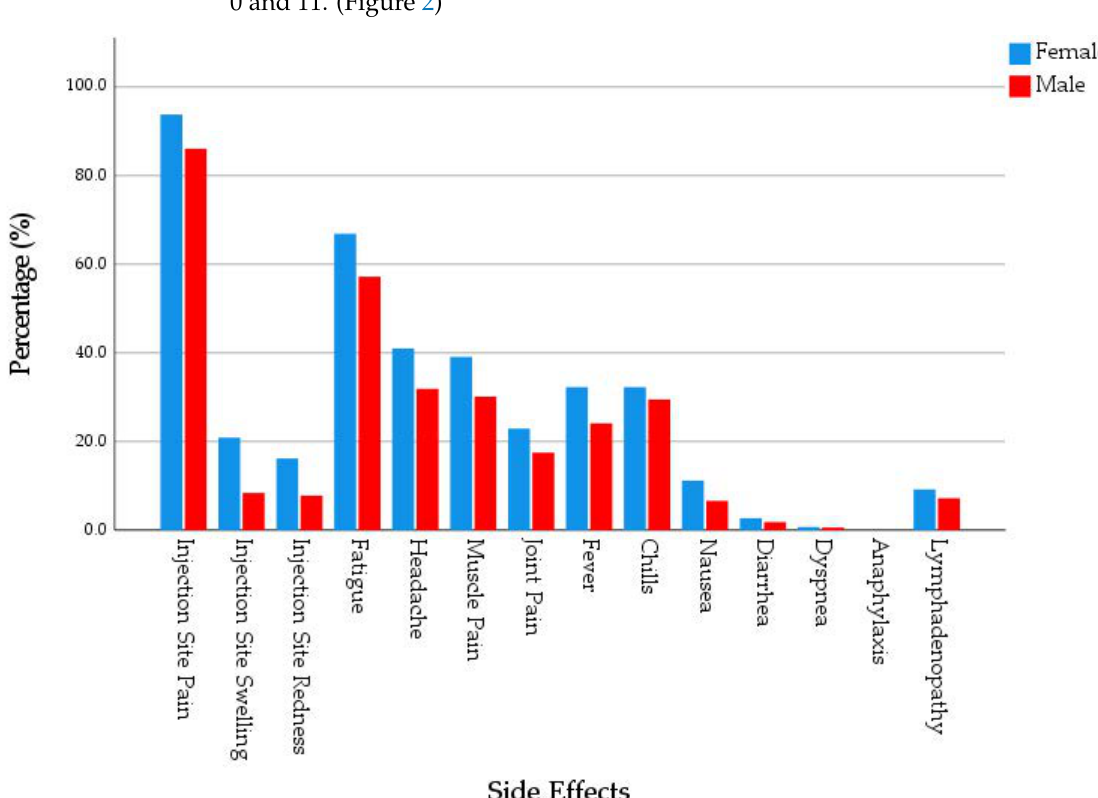
Figure 2. Side Effects of mRNA-based COVID-19 Vaccines Experienced by Young Adults (18–30 years old), Czech Republic, April–June 2021 ( n =